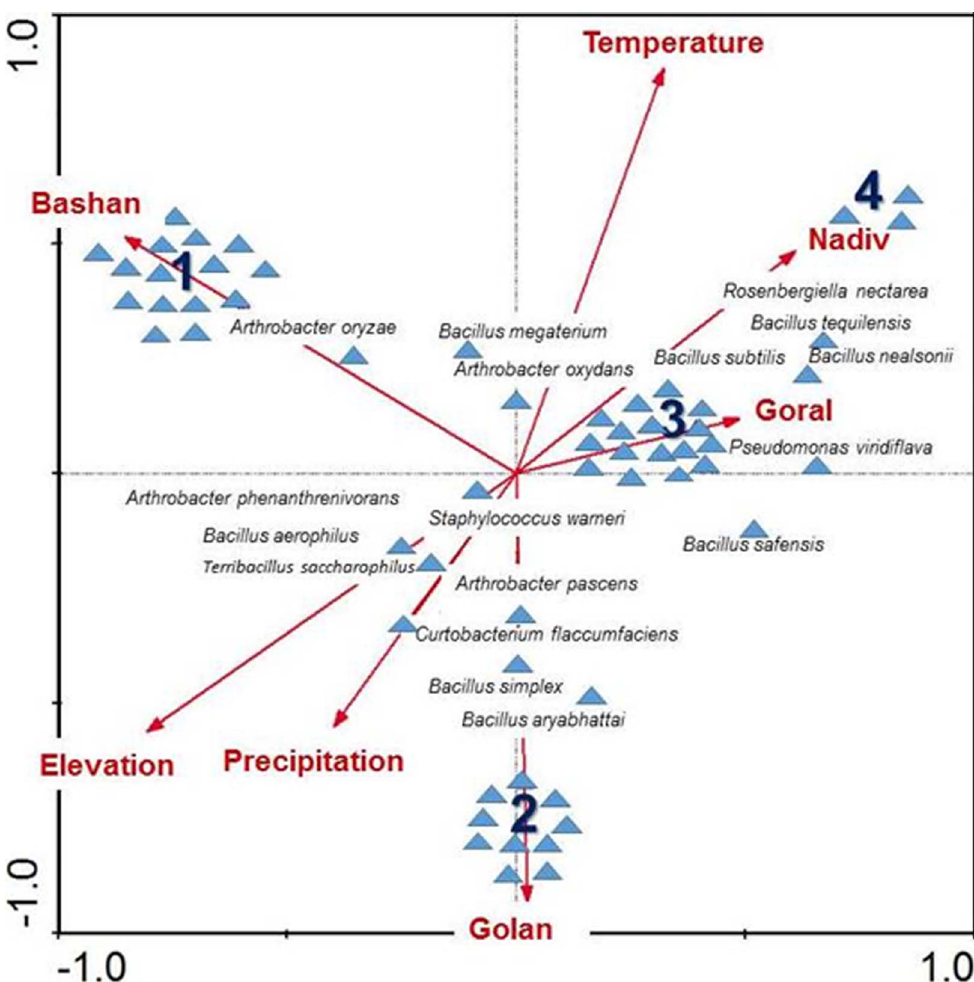
Figure 5. Variation of bacterial species isolates among the four different sites (Goral, Nadiv, Bashan and Golan) as shown by the ordination diagram (CCA). The distribution of bacterial species along the ordinates was not random (Monte Carlo test; F =1.41, P , 0.005) and thus can be explained by their different locations along the climatic gradient. The first two ordination axes explained 74.1% of the variance of species- environment relation. Identity of the species related to a single site is as follows: Group 1: Agromyces salentinus , Leuconostoc holzapfelii, Pseudomonas lini, Arthrobacter chlorophenolicus, Lysinibacillus sinduriensis, Pseudomonas syringae, Bacillus endophyticus, Microbacterium foliorum, Staphylococcus cohnii subsp. cohnii, Bacillus flexus, Pseudomonas baetica, Staphylococcus epidermidis, Brevibacterium frigoritolerans, Pseudomonas cedrina subsp. fulgida, Staphylococcus hominis subsp. hominis . Group 2: Lonsdalea quercina, Arthrobacter humicola, Pantoea eucalypti, Brevibacillus agri, Pseudomonas azotoformans, Erwinia persicina, Pseudomonas congelans, Gluconobacter kondonii, Gluconobacter morbifer, Gluconobacter sphaericus . Group 3: Arthrobacter nitroguajacolicus, Bacillus anthracis, Bacillus licheniformis, Bacillus mojavensis, Bacillus niacin, Bacillus sonorensis, Erwinia toletana, Fictibacillus nanhaiensis, Flavimonas oryzihabitans, Pseudomonas graminis, Pseudomonas koreensis, Pseudomonas lutea, Pseudomonas mohnii, Scopulibacillus darangshiensis, Staphylococcus arlettae, Staphylococcus cohnii subsp. urealyticus . Group 4: Acinetobacter boissieri, Acinetobacter nectaris, Neokomagataea tanensis .